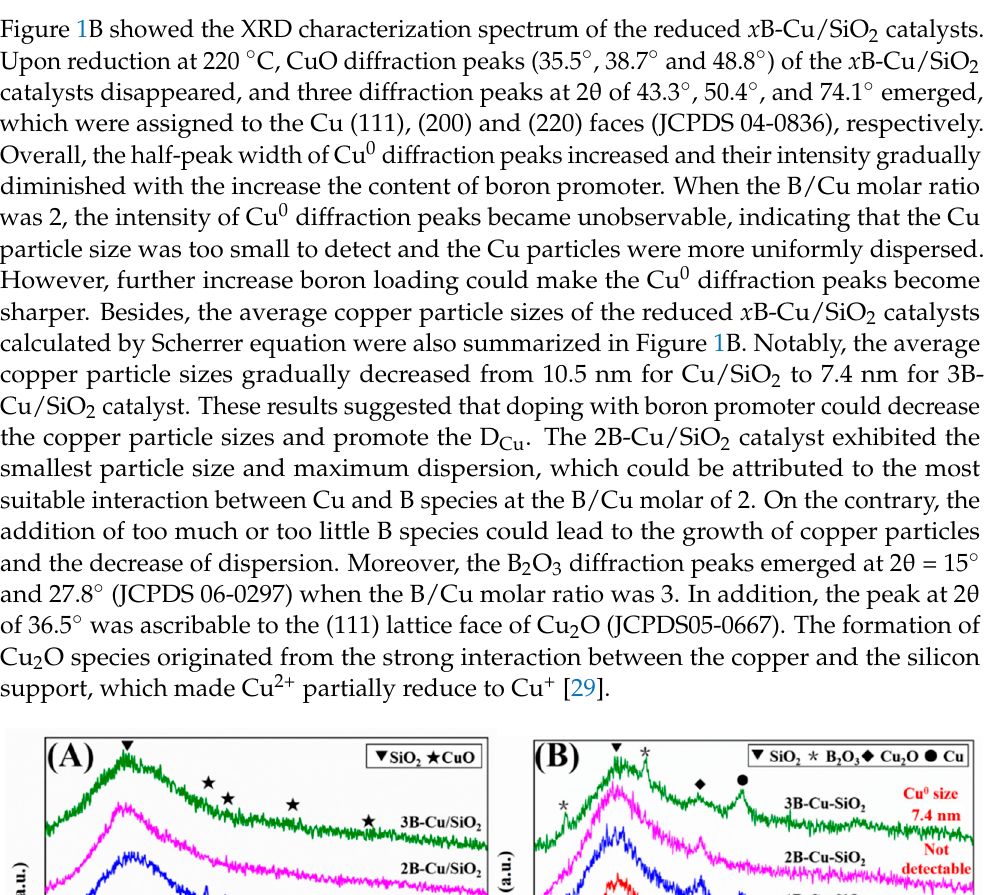
Figure 1B showed the XRD characterization spectrum of the reduced x B-Cu/SiO 2 catalysts. Upon reduction at 220 ◦ C, CuO diffraction peaks (35.5 ◦ , 38.7 ◦ and 48.8 ◦ ) of the x B-Cu/SiO 2 which were assigned to the Cu (111), (200) and (220) faces (JCPDS 04-0836), respectively.